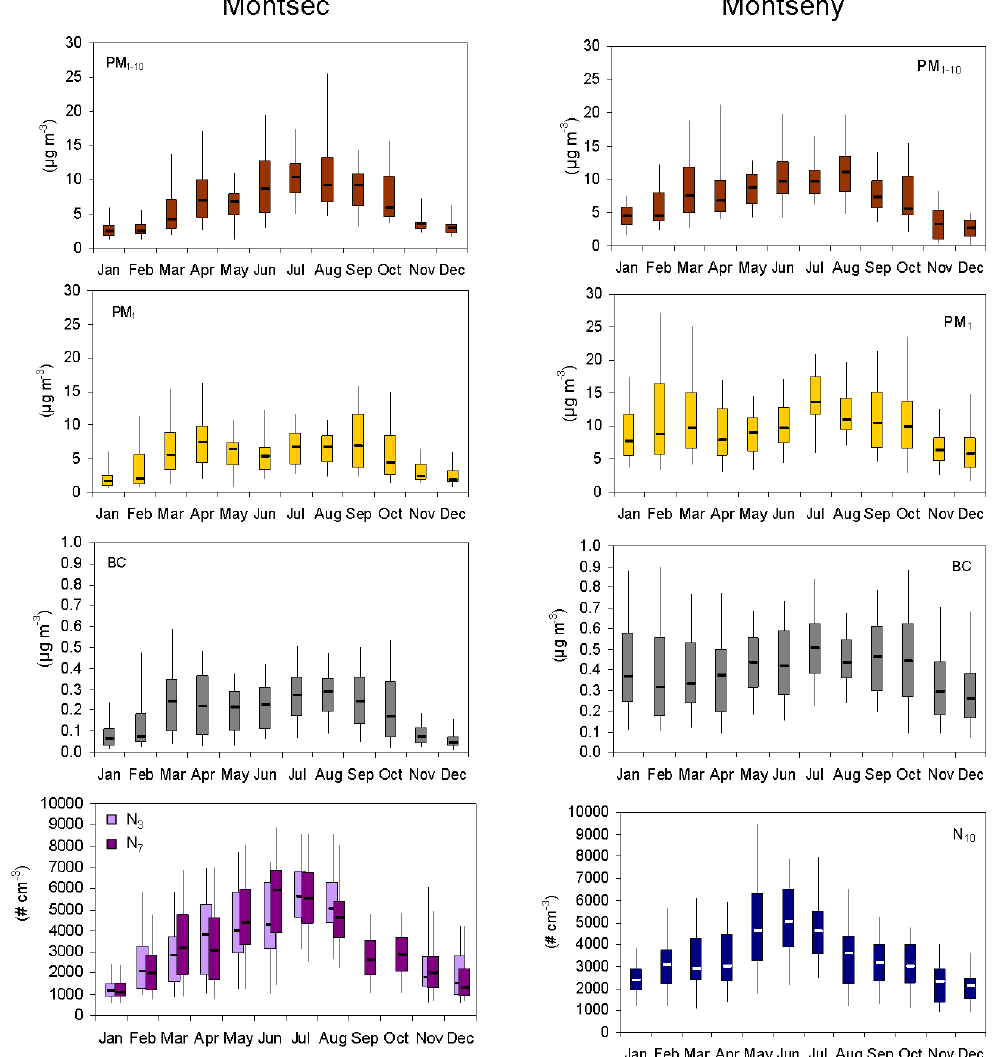
Fig. 10. Monthly median (black line within the boxes) and percentiles (5-25-75-95, boxes and whiskers) of daily PM 1 − 10 , PM 1 , BC and N concentrations during the study period at the Montsec and Montseny sites.